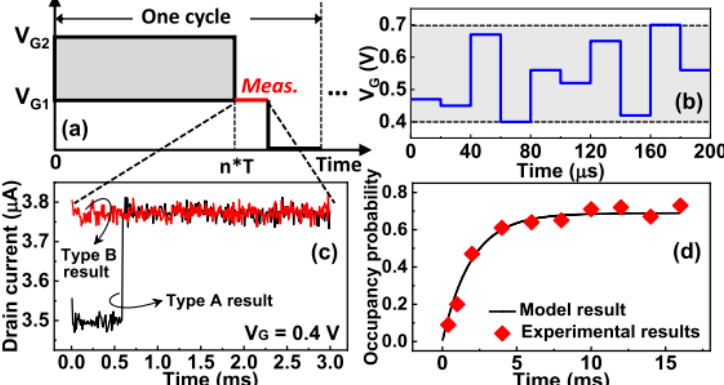
Figure 44. ( a ) Measurement schematic illustration for occupancy probability estimation, ( b ) randomly generated complex waveform for one period, ( c ) measured window to judge trap state after complex waveforms for each cycle, and ( d ) comparison between the extracted occupancy probability in experiments and model results [312].